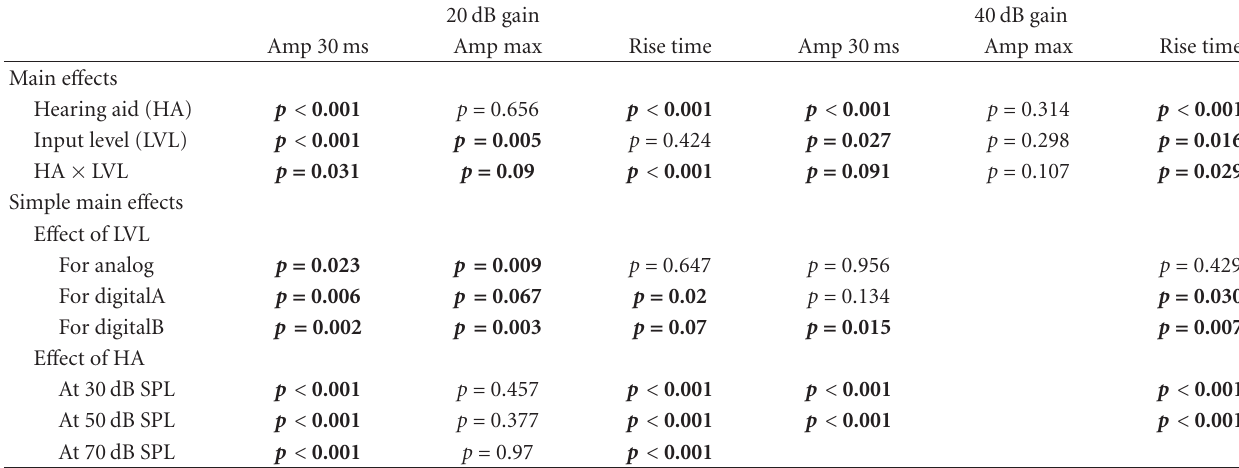
Table 4: ANOVA results for all measures of the long stimulus. Shown are p values of the ANOVA and of the simple main e ff ects, where appropriate. 20 dB gain 40dB